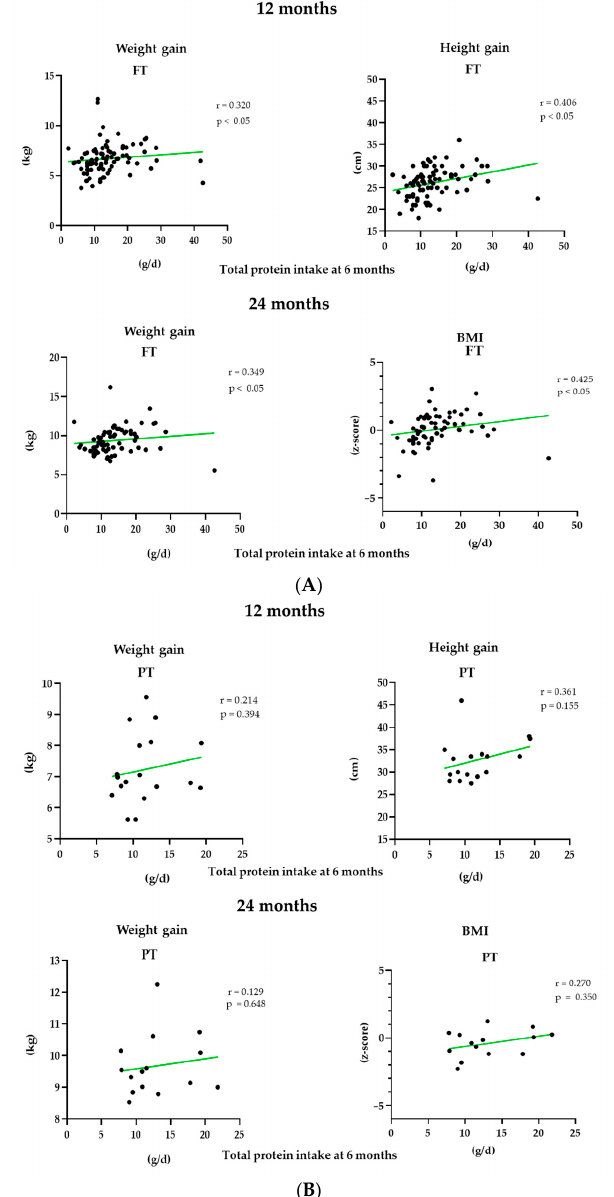
Figure 5. Spearman correlation in FT infants ( A ) and PT ( B ) between total protein intake at 6 months (g/d) and the different anthropometric parameters weight and height gain and BMI z-score at 12 and 24 months.